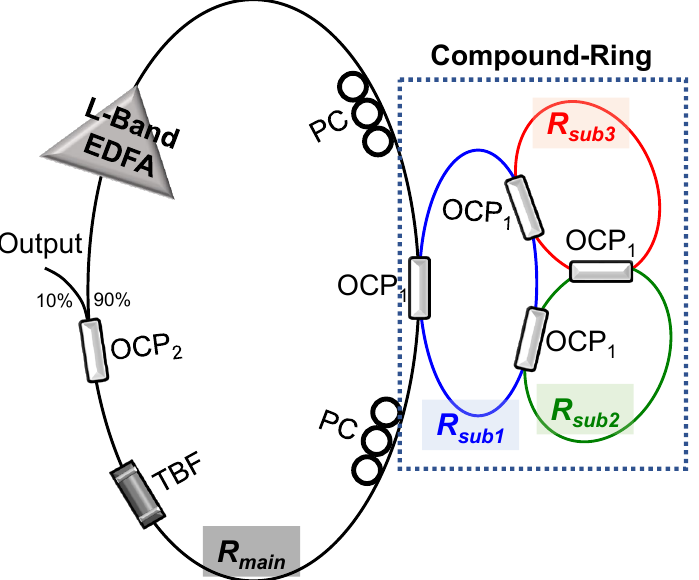
Figure 1. Experimental setup of designed L-band EDF laser with compound-ring configuration.